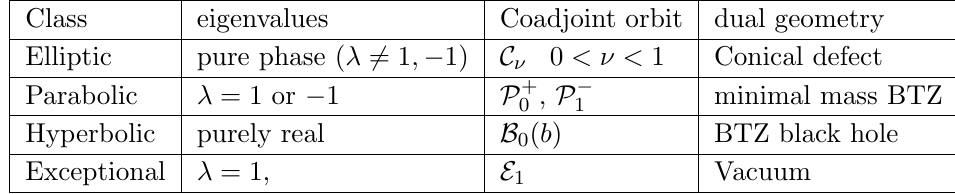
Table 1. A characterisation of the relevant monodromy classes their associated Virasoro coadjoint orbit and the geometry of the holographic dual (following [30,